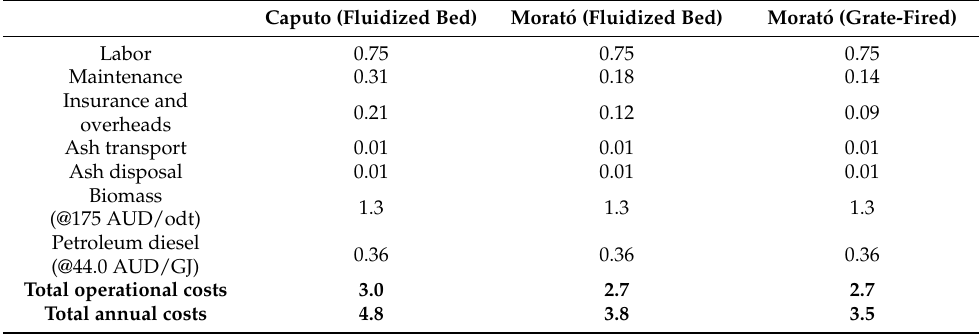
Table 5. Operational costs associated with running an electricity plant with directly combusted biomass. All costs are in AUD